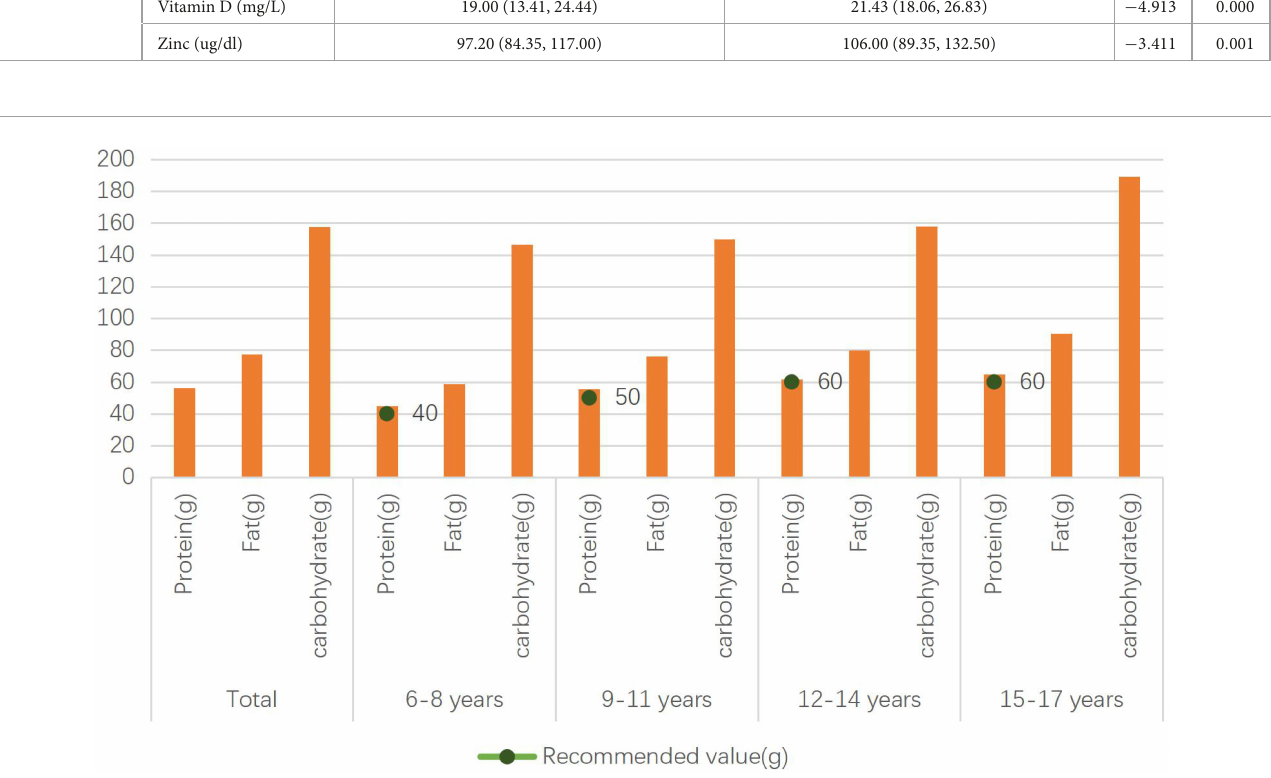
FIGURE1 Protein, fat, and carbohydrate intake of rural children and